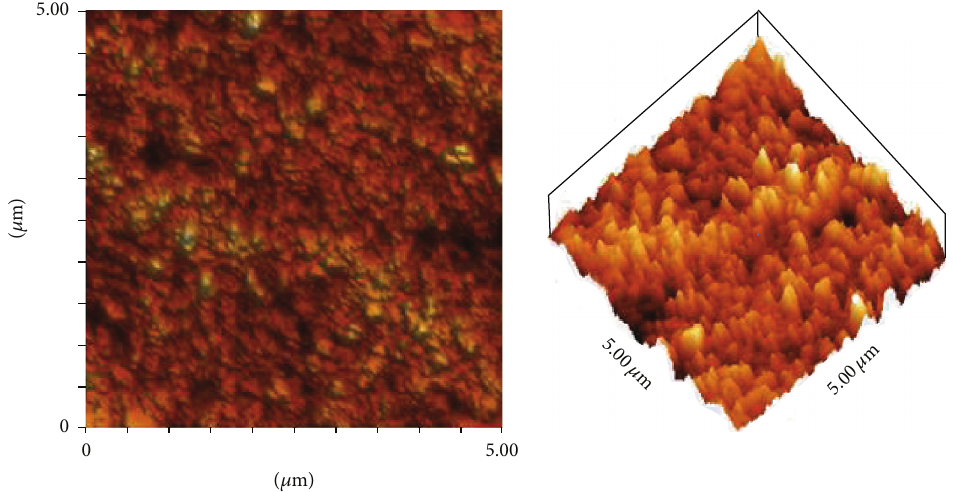
Figure 1: Two- and three-dimensional AFM images of TiO 2 -P25 nanoparticles immobilized on glass plate.